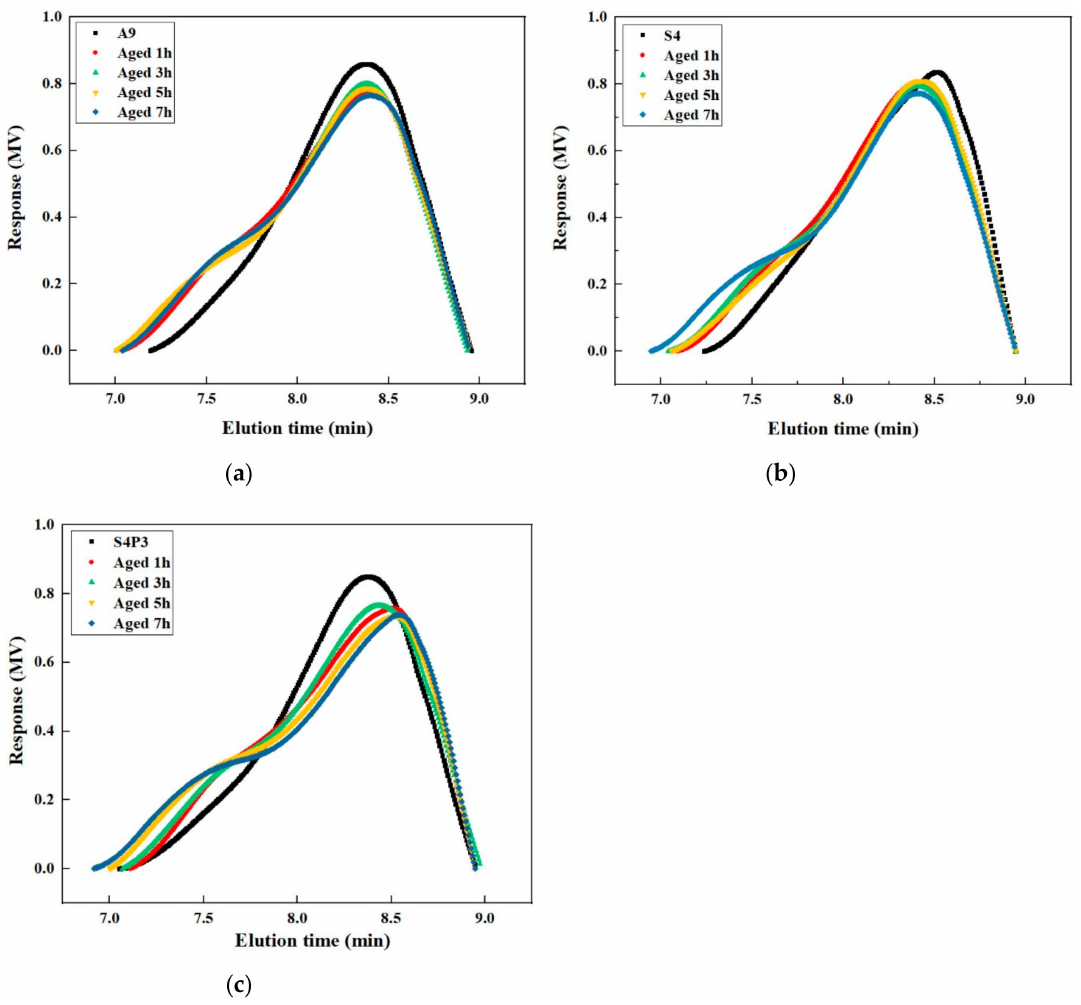
Figure 10. GPC evolution of asphalt binders at di ff erent aging times. ( a ) A9; ( b ) S4; ( c ) S4P3. Table 6. Molecular weight evolution of di ff erent asphalt